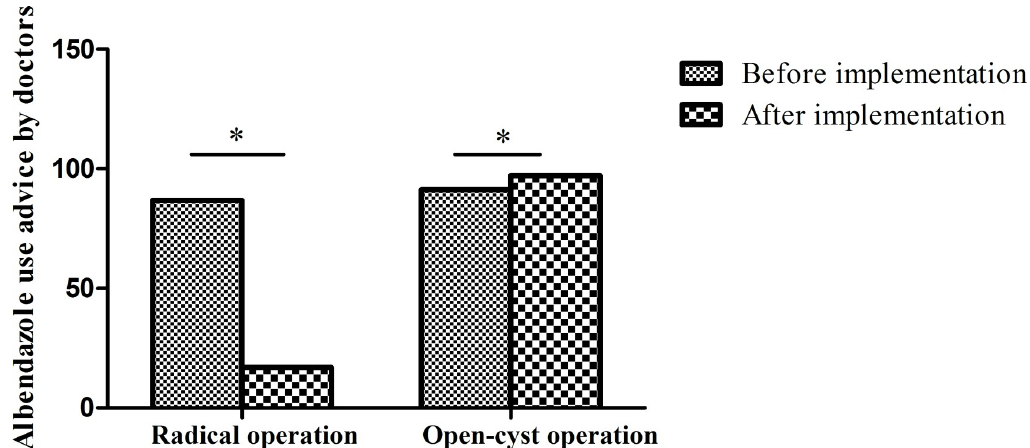
Fig 6. Postoperative discharge guidance for abendazole use following radical and open-cyst operation. Based on doctors’ discharge advice, the recommendation to use abendazole following open-cyst operations increased after implementation, while recommendations to use abendazole after radical operations significantly decreased. ( � p < 0.001 by the chi-square test).